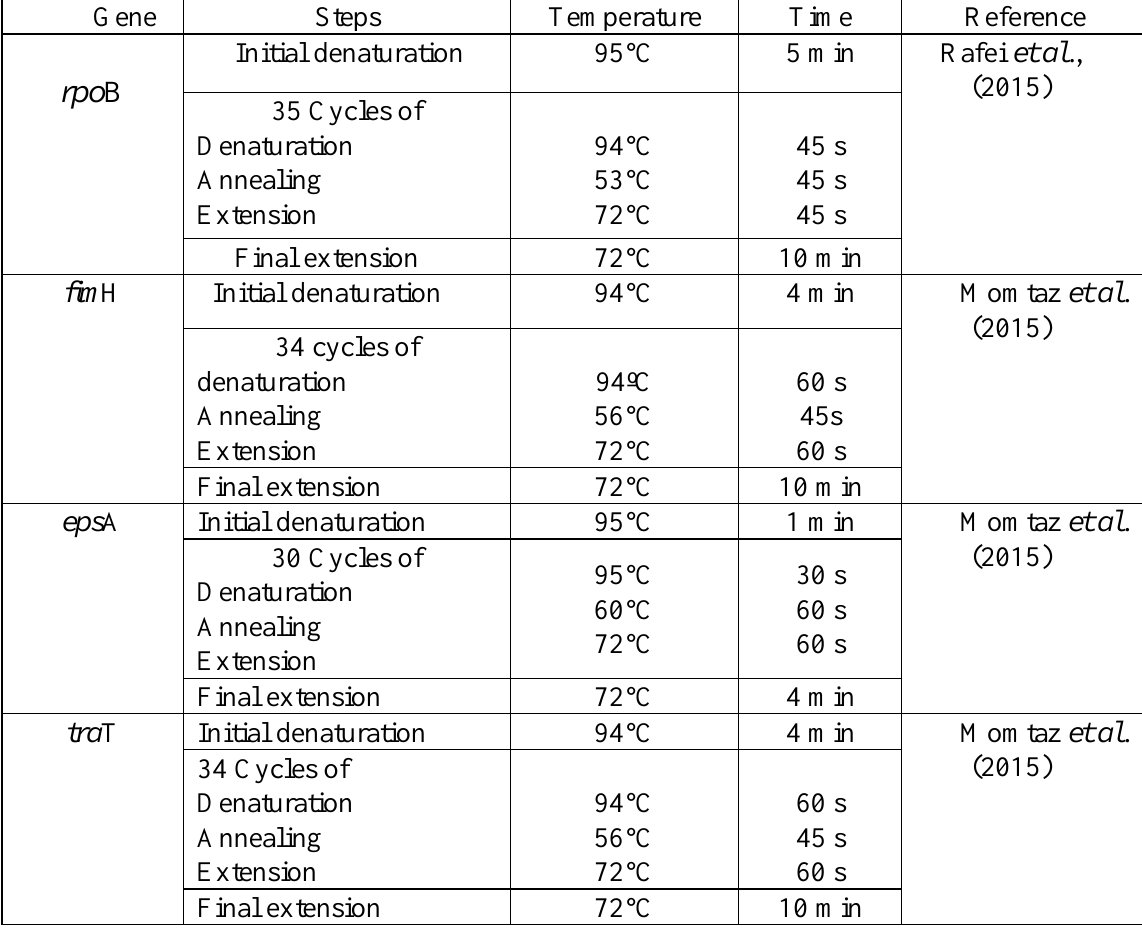
Table 2: PCR Cycle conditions of rpo B, fim H, eps A, and tra T gene